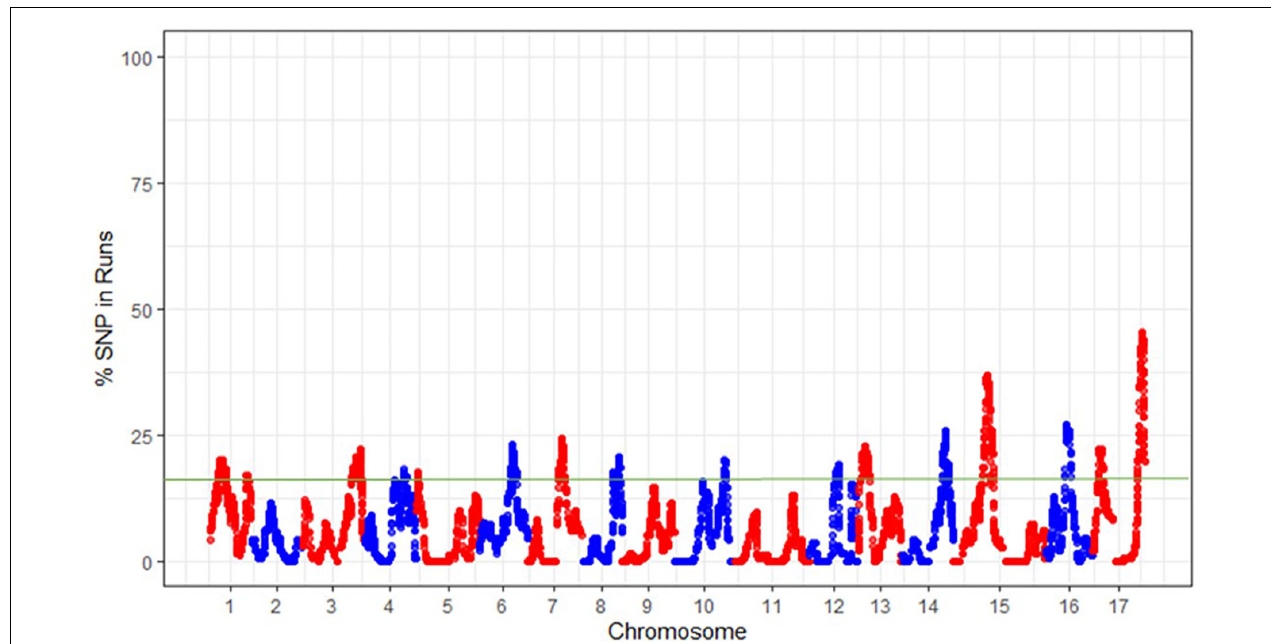
FIGURE 5 | The frequency (%) of single nucleotide polymorphisms (SNPs) occurrence into runs of homozygosity (ROH) islands across the pear ( Pyrus spp.) genome. The green horizontal line indicates the adopted threshold (15%), which defines the ROH